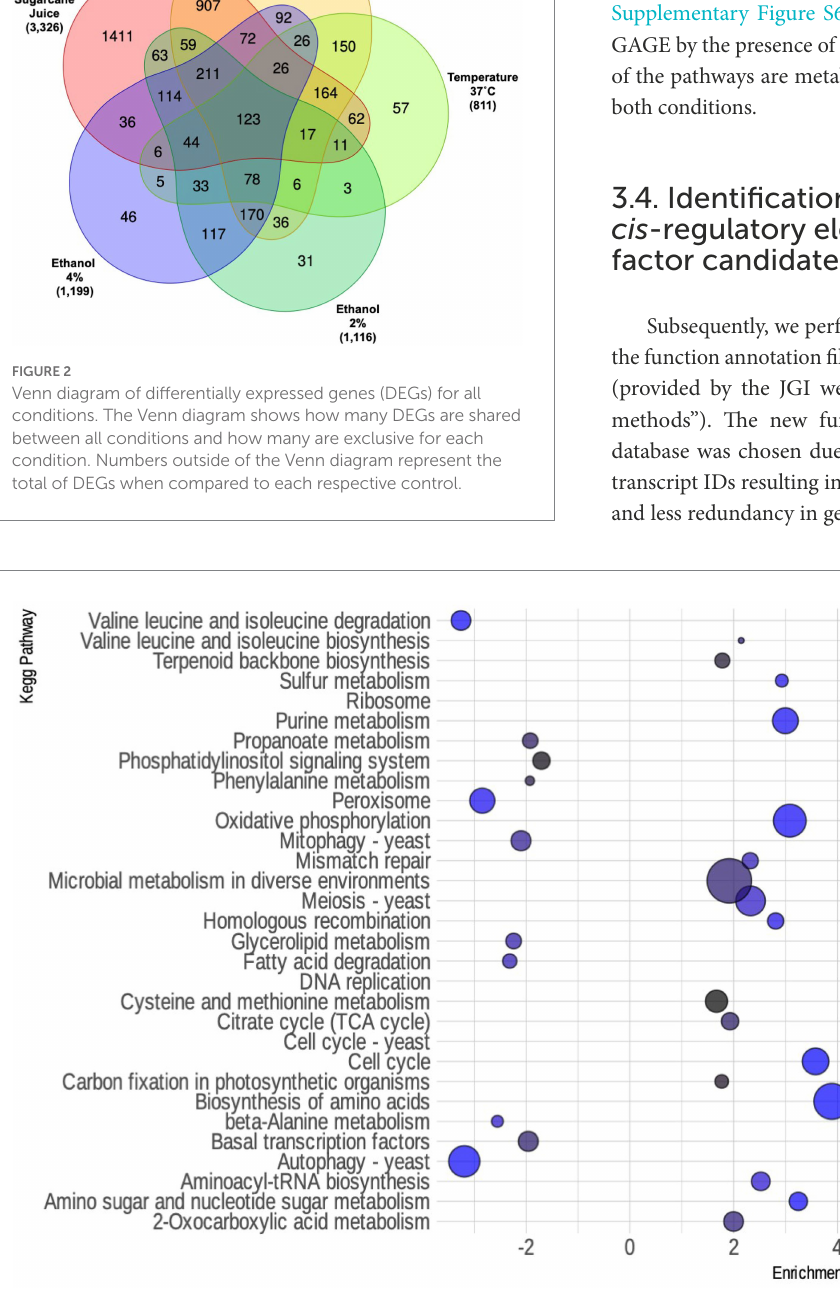
FIGURE 3 Enriched kyoto encyclopedia of genes and genomes (KEGG) pathways for Rhodosporidium toruloides grown on sugarcane juice (SCJ). Bubble map showing the biochemical pathways of R. toruloides noted by KEGG enriched in the SCJ condition, as obtained by the GAGE package. Pathways that have an enrichment value greater than 0 are up-regulated, while those that have a value less than 0 are down-regulated. Blue scale inside the bubbles represents the decreasing value of p s. The different sizes of the bubbles define the approximate number of DEGs in each biochemical